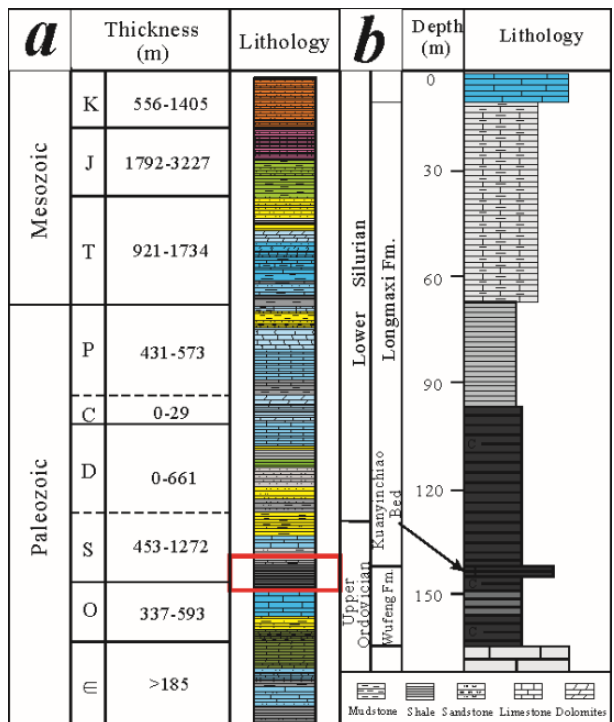
Figure 1. ( a ) Schematic stratigraphic units of the southern Sichuan Basin. ( b ) Stratigraphic column of the Upper Ordovician – Lower Silurian Formation of CN well in the study area.